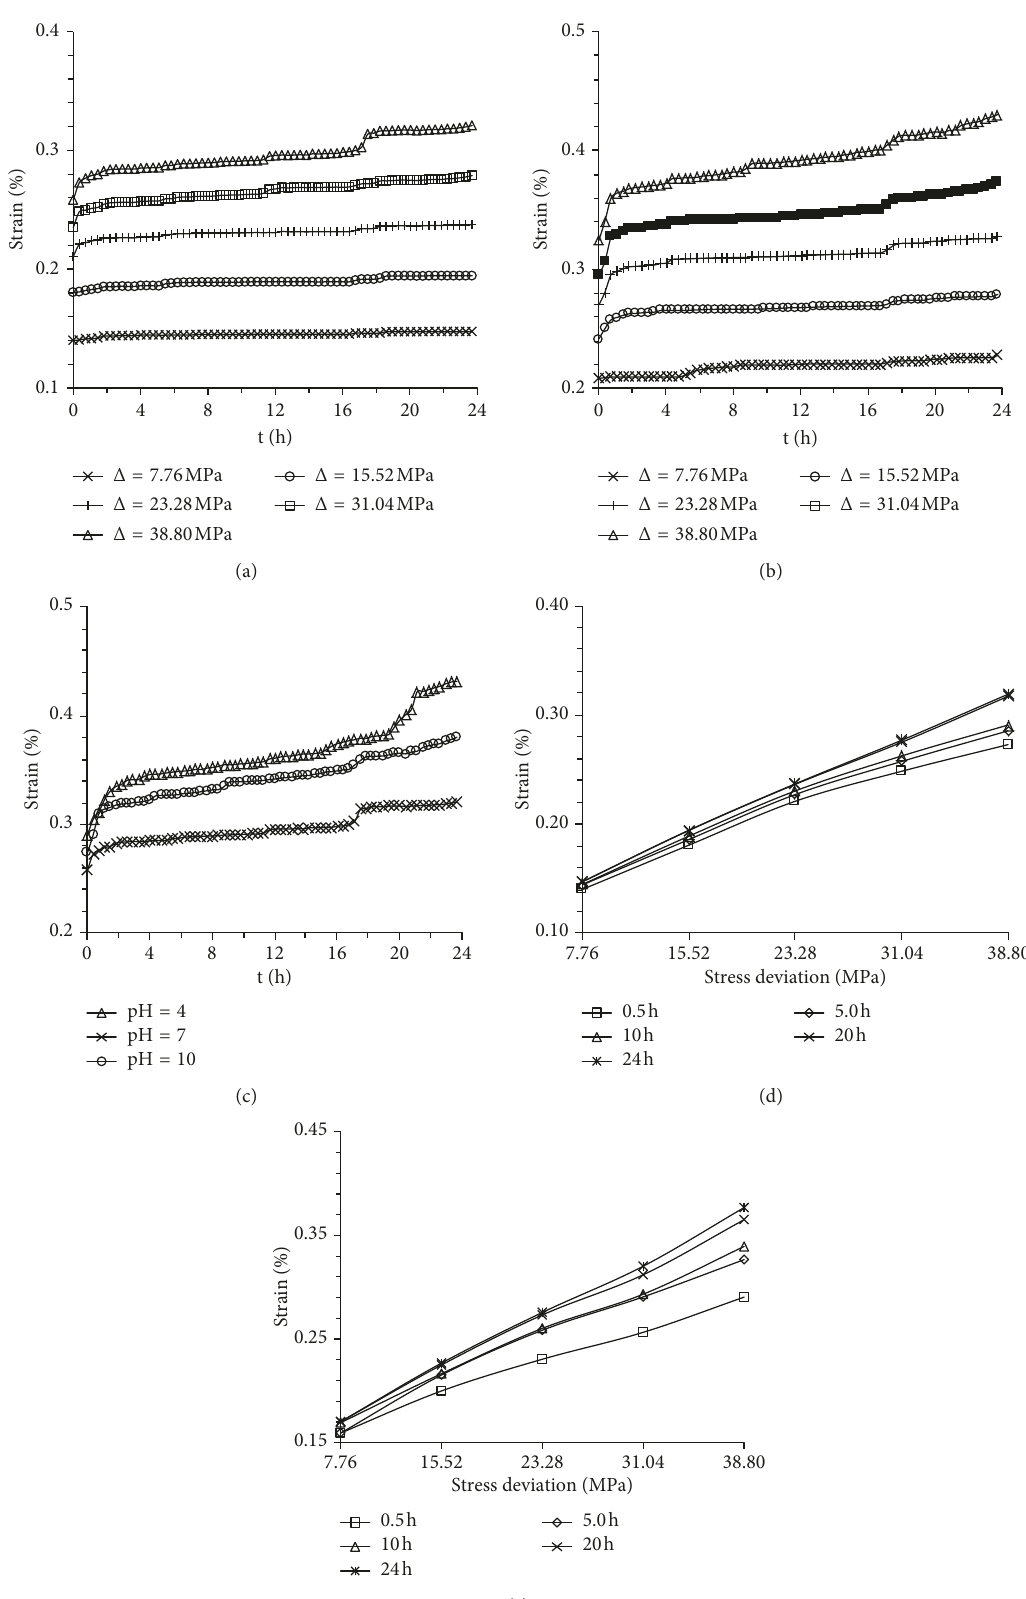
Figure 5: Influence of different pH values on creep properties of shale. (a) Strain-time curves (pH (c) Creep strains under different pH values (stress deviation is 38.80MPa). (d) Isochronous stress deviation-strain curves (pH (e) Isochronous stress deviation-strain curves (pH